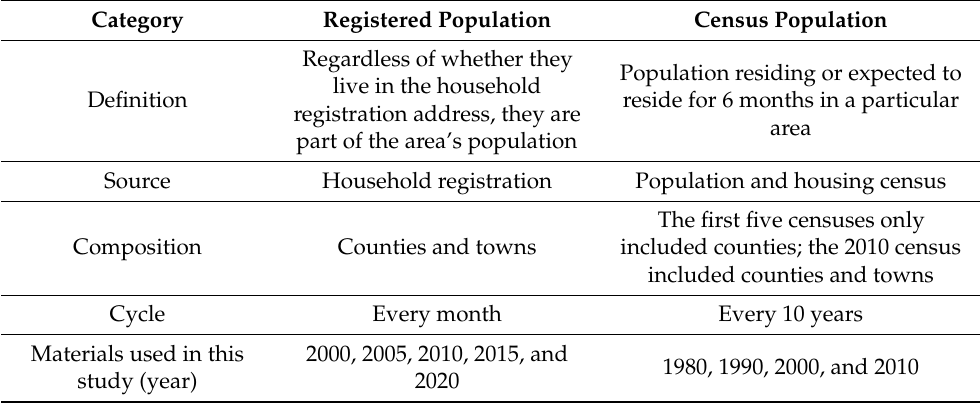
Table 2. Comparison of registered and census